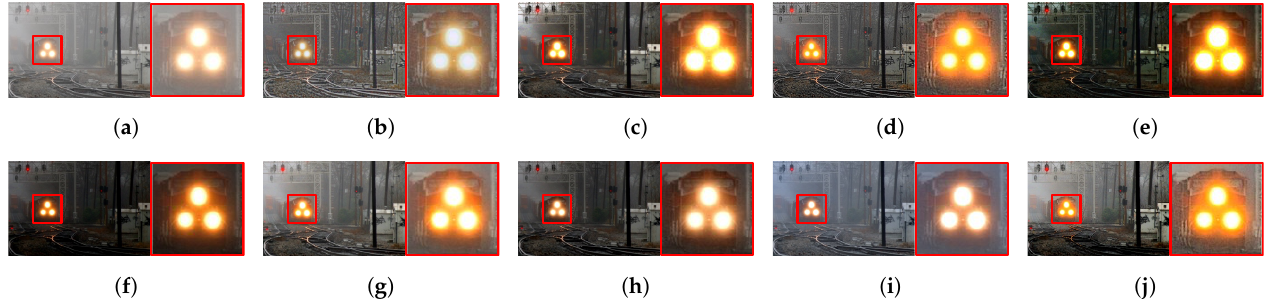
Figure 19. A qualitative comparison of different dehazing methods on a real hazy image of a train. ( a ) Hazy image, and results by ( b ) Tarel and Hautiere [35], ( c ) He et al. [21], ( d ) Kim et al. [36], ( e ) Bui and Kim [50], ( f ) Zhu et al. [52],